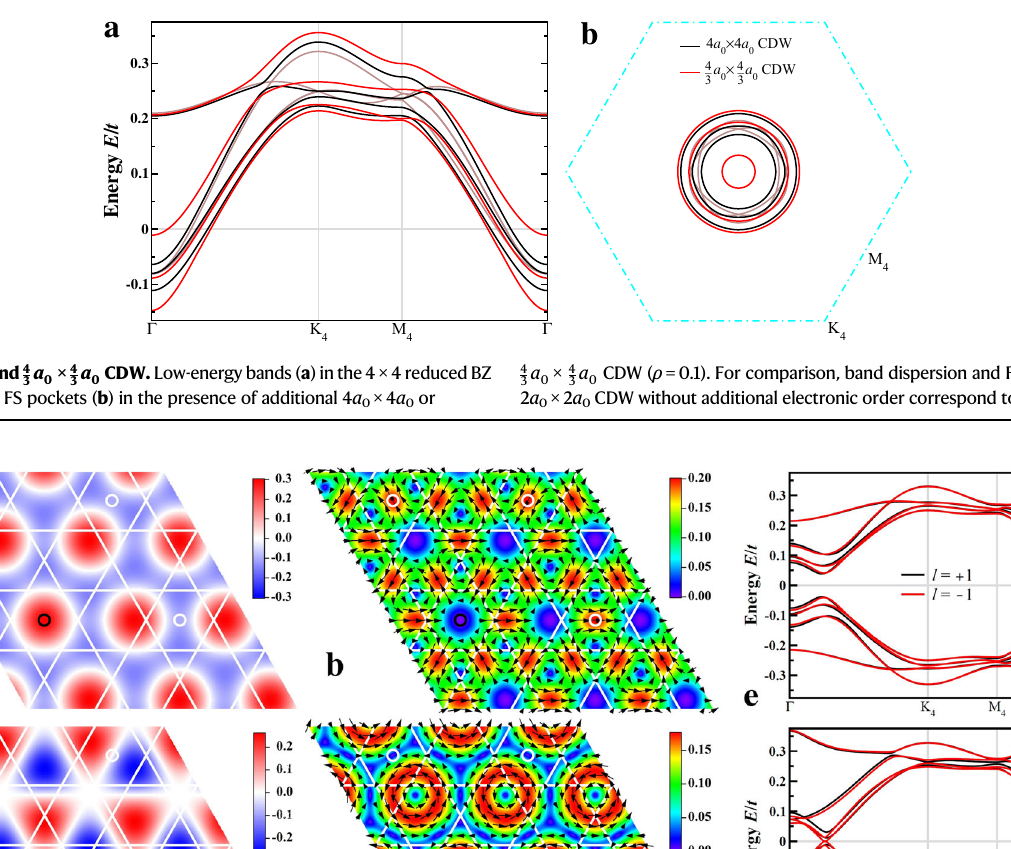
quasiparticle bands for PDW 0 ±1 . In ( a and c ), order parameters are real and repre- sented by color intensity. In ( b and d ), order parameters are complex, with amplitude represented by color intensity and phase denoted by